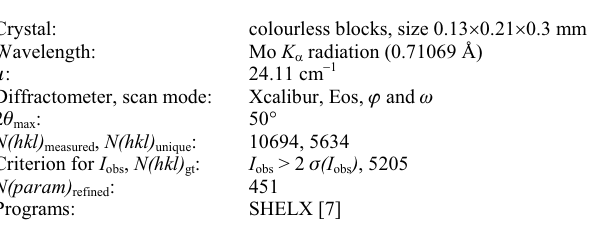
Table 1. Data collection and handling.